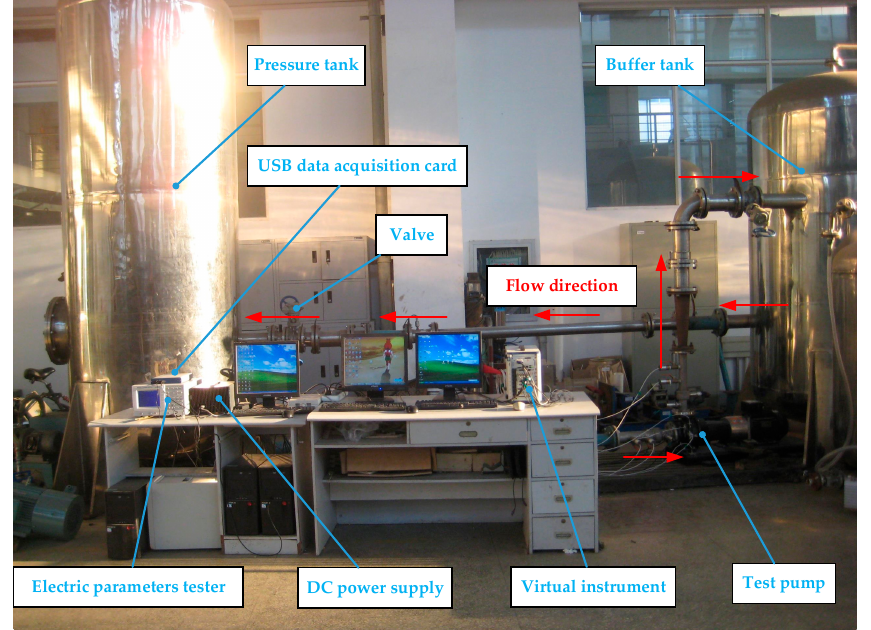
Figure 1. Schematic of the experimental test rig.